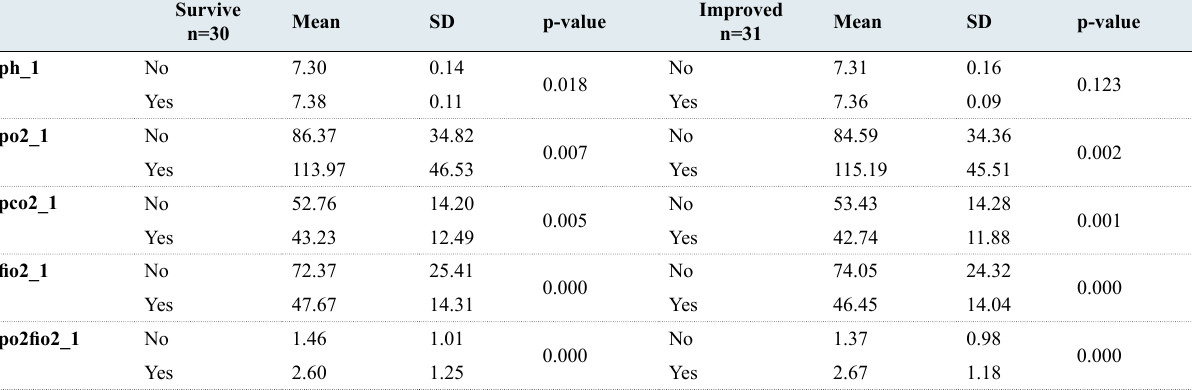
Table 3: ABG Values at 1 hour after initiating noninvasive ventilation Survive n=30